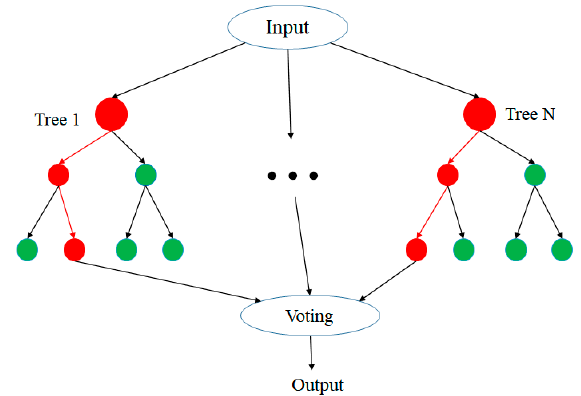
Figure 5. Conceptual representation of random forest algorithm.